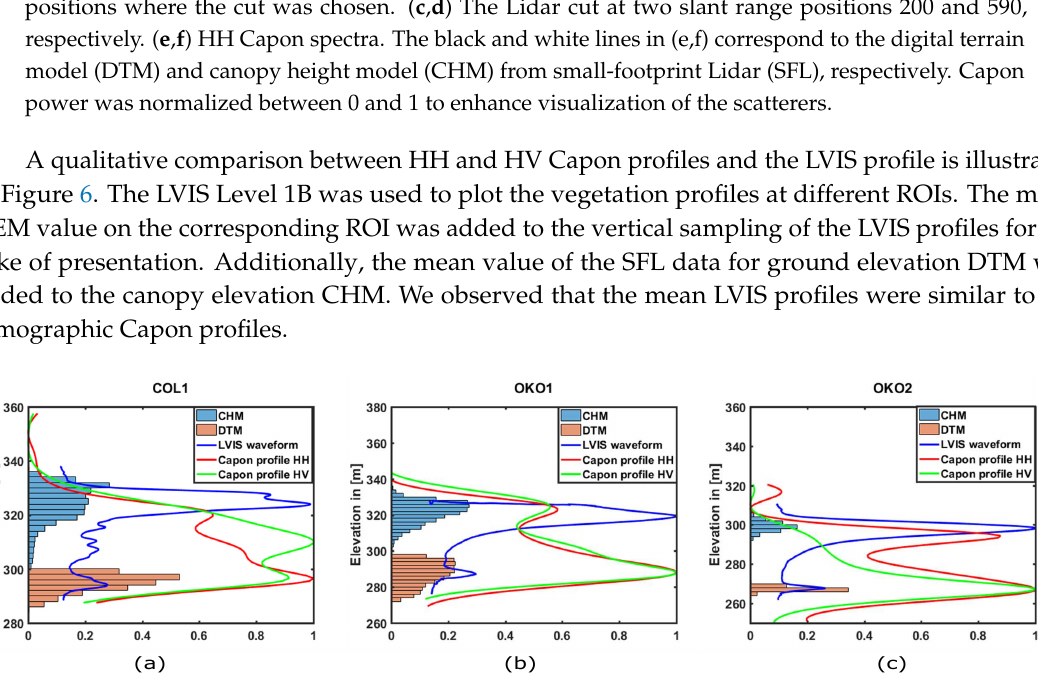
Figure 6. Regions of interest (ROIs) named ( a ) COL1, ( b ) OKO1, and ( c ) OKO2 in Gabon Lopé Park. HH (in red) and HV (in green) Capon profiles. Capon power and LVIS waveform power were normalized between 0 and 1. The histograms of SFL canopy and ground elevations are presented respectively in blue and brown. The blue curve corresponds to LVIS waveform Level